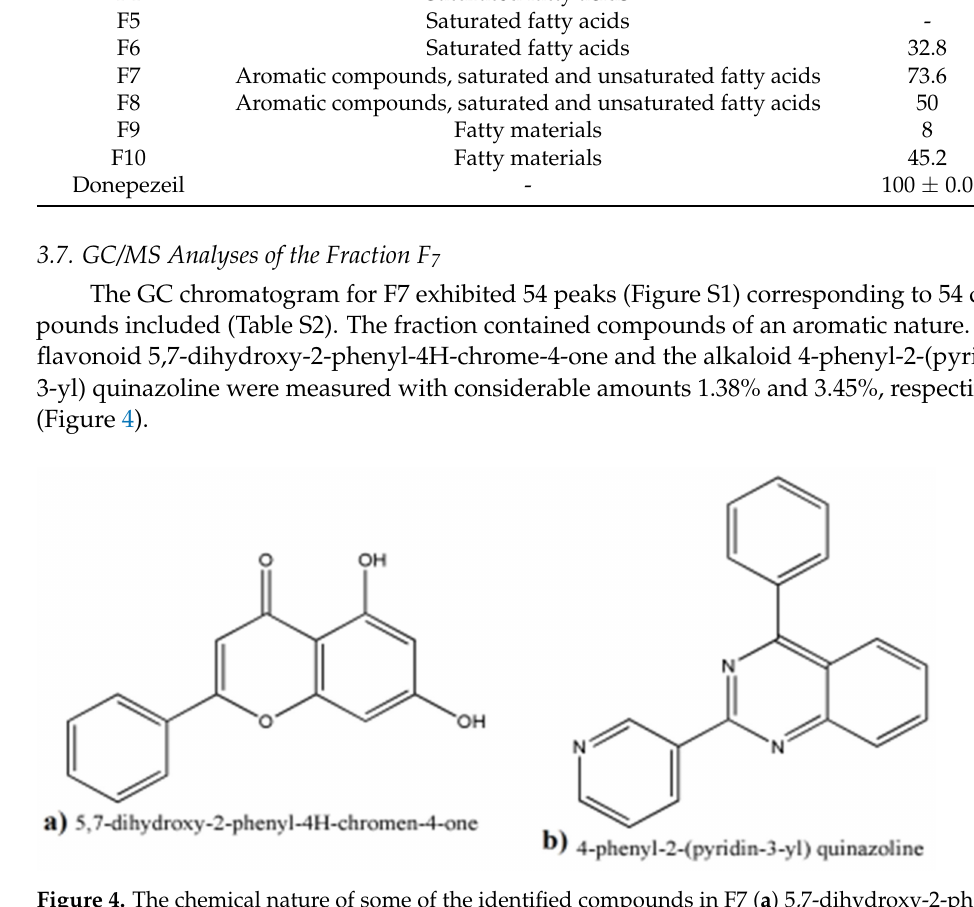
Figure 4. The chemical nature of some of the identified compounds in F7 ( a ) 5,7-dihydroxy-2-phenyl- 4H-chrome-4-one and ( b ) 4-phenyl-2-(pyridin-3-yl) quinazoline compounds. 3.8. Alignments and Docking Poses of DHI, Donepezil, 5,7-dihydroxy-2-phenyl-4H-chrome-4-one and 4-phenyl-2-(pyridin-3-yl)